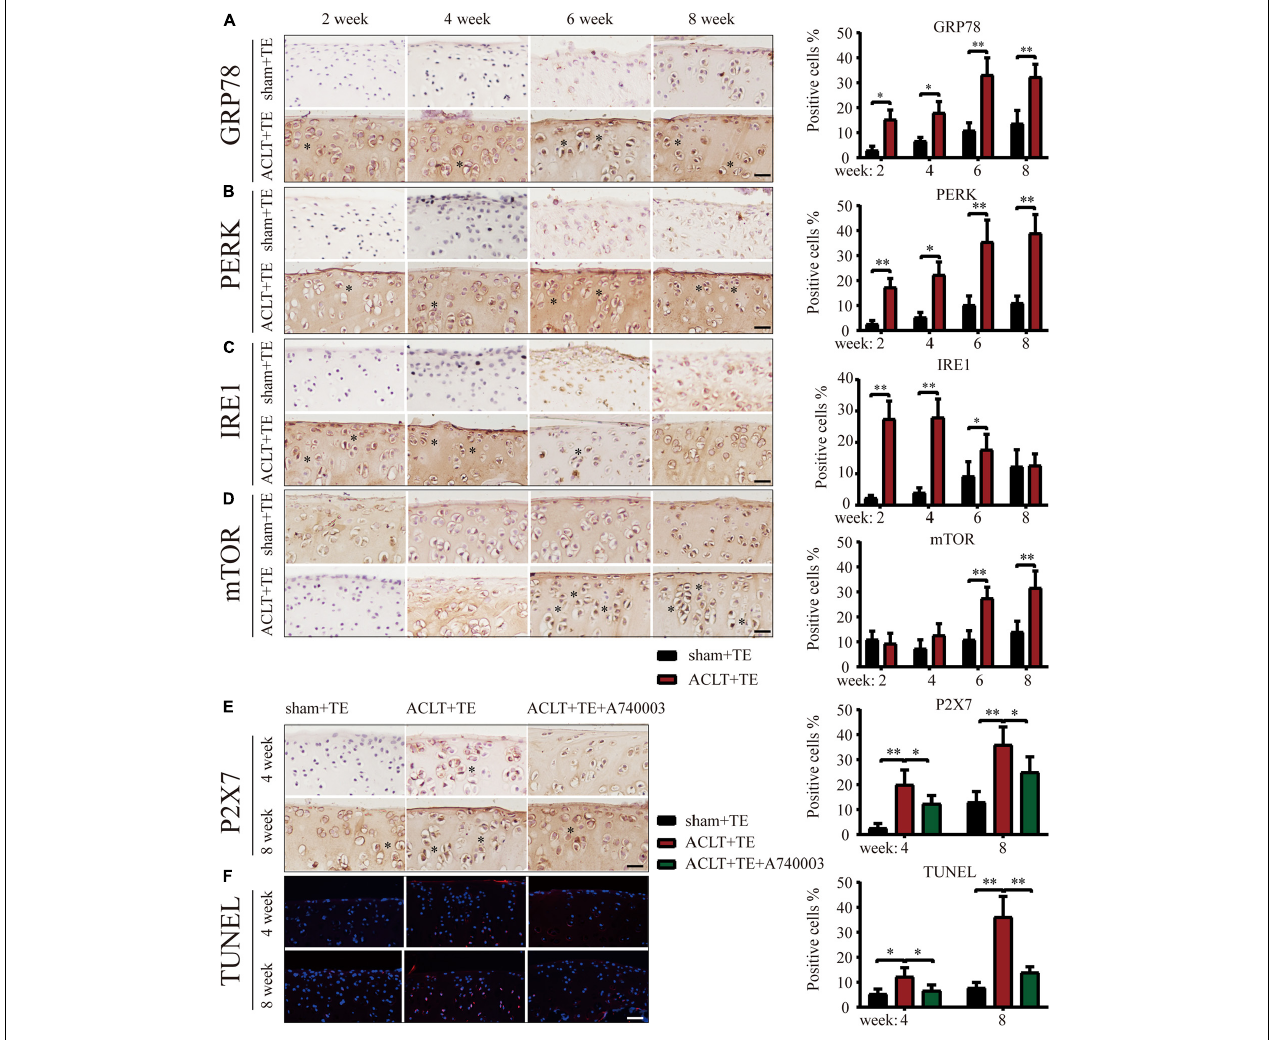
FIGURE 2 | Treadmill exercise (TE) affects autophagy and ER stress-apoptosis through the regulation of P2X7 activity. IHC staining and quantification of the ER stress markers GRP78 (A) , PERK (B) , IRE1 (C) , and mTOR (D) were performed to observe the changes in their expression levels over time. Quantification of the stained cells is shown on the right. IHC staining and quantification of P2X7 expression levels (E) in the sham + TE, ACLT + TE, and ACLT + TE + A740003 groups at 4 and 8 weeks (scale bar: 200 µ m). Quantification of the stained cells is presented on the right. TUNEL staining (F) showing the changes in the percentage of apoptotic chondrocytes following the intra-articular injection of the P2X7 inhibitor A740003 (scale bar: 200 µ m). Quantification of the stained cells is presented on the right. The asterisk in the HE and TB staining images represents the cartilage damage site, and the asterisk in the histochemical images represents the positively stained cells. Data are expressed as means ± standard deviations of at least three independent experiments. ∗ p < 0.05, ∗∗ p <